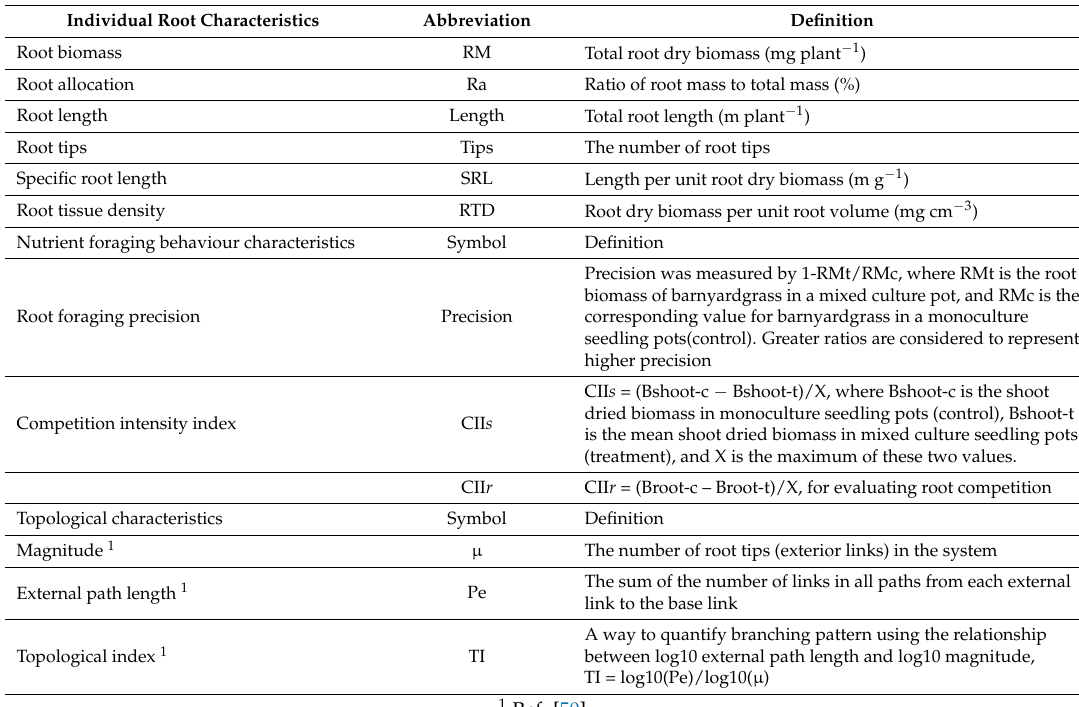
Table 2. Definitions of individual root traits, nutrient foraging behavior characteristics and root architecture